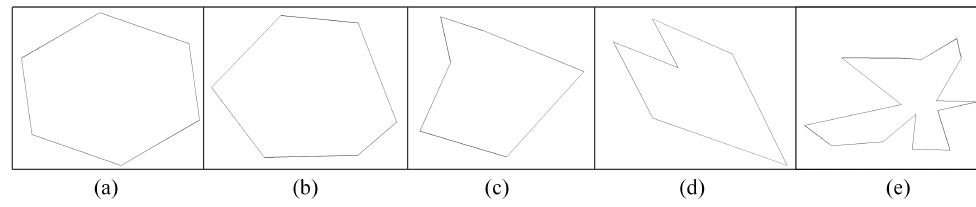
Figure 4. Examples of generated random polygons. n denotes the number of vertices, (cid:101) denotes irregularity, and σ denotes spikiness. ( a ) n = 6, (cid:101) = 0, σ = 0. ( b ) n = 6, (cid:101) = 0.5, σ = 0. ( c ) n = 6, (cid:101) = 0, σ = 0.5. ( d ) n = 6, (cid:101) = 0.7, σ = 0.7. ( e ) n = 15, (cid:101) = 0.7, σ =